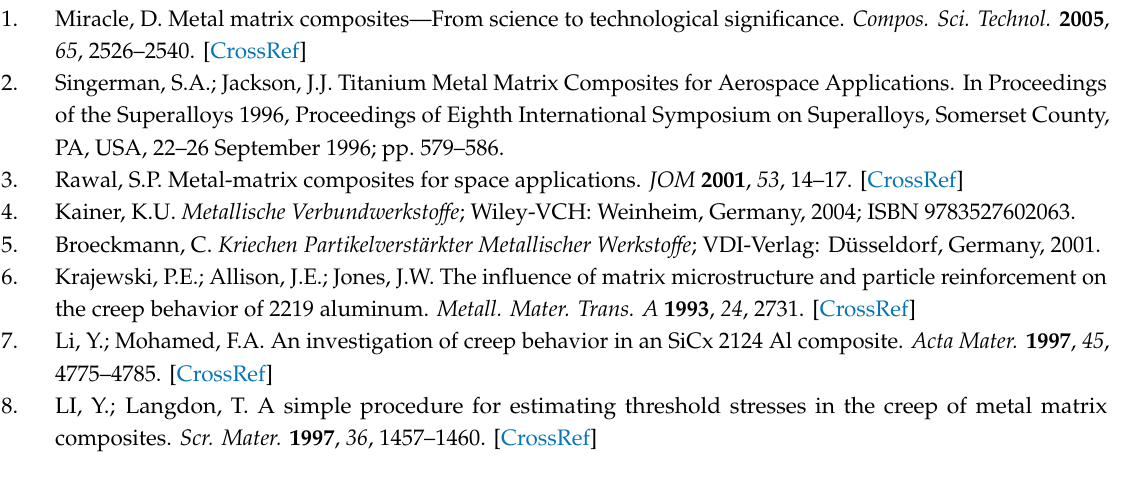
Figure S1: AA6061 + 22% Al 2 O 3 , pore formation, Figure S2: AA6061 + 22% Al 2 O 3 , pore growth, Figure S3: Ti-MMC, pore formation, Figure S4: Ti-MMC, pore growth, Video S1: Ti-MMC at 0.77 tfr, Video S2: Ti-MMC at 0.77